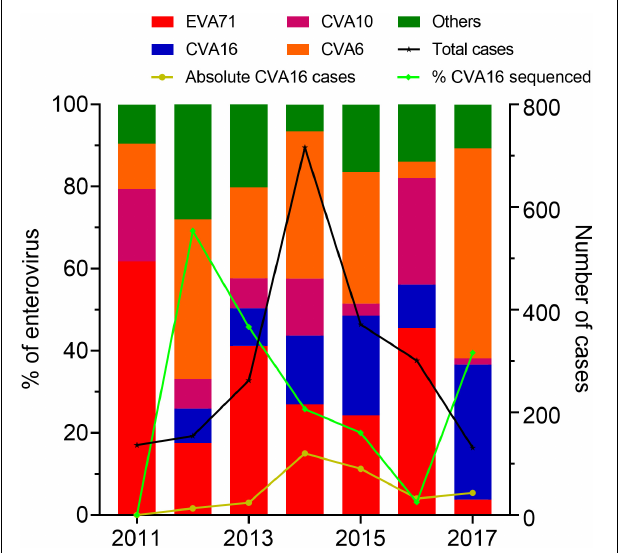
FIGURE 1 | Enterovirus prevalence among HFMD cases in Vietnam during 2011–2017. The left Y axis shows the proportions of enterovirus serotypes detected among cases enrolled in the present study and the proportions of CVA16 cases included for whole genome sequencing. The right Y axis shows number of HFMD cases enrolled in the study between 2011 and